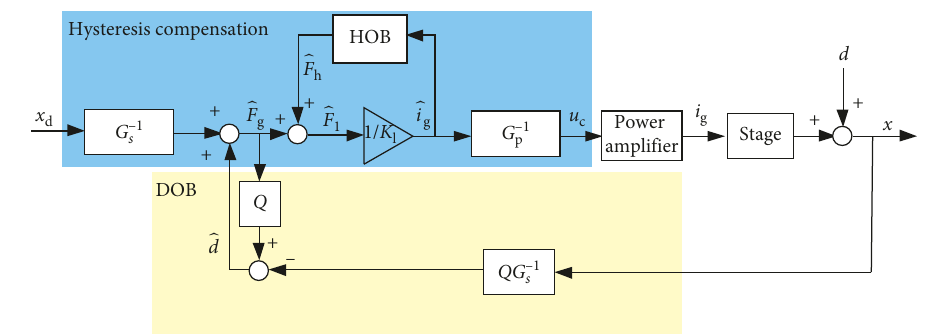
Figure 4: Scheme framework of the disturbance